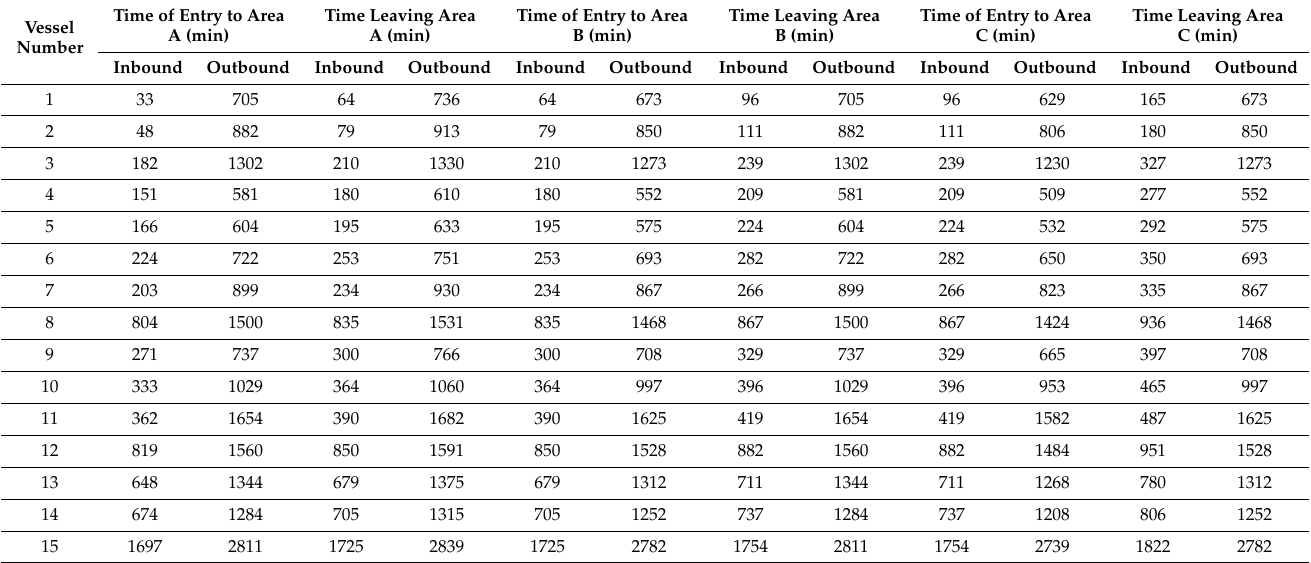
Table 8. Time data for vessels entering and leaving areas A, B, and